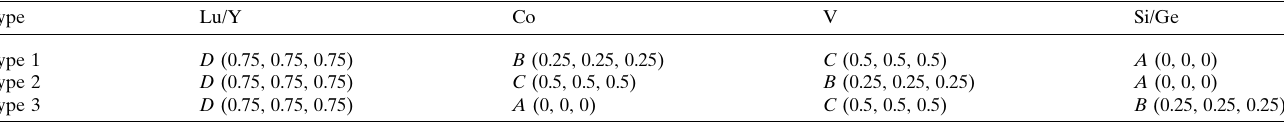
Table 1 Atomic positions of the crystal structure at different crystal sites for the three types of M CoV Z ( M = Lu, Y; Z = Si, Ge) compounds. Type